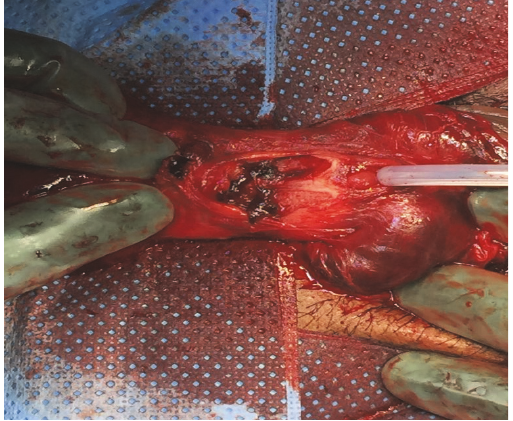
Figure 2: Intraoperative finding of bilateral corpora cavernosa with complete urethral rupture.